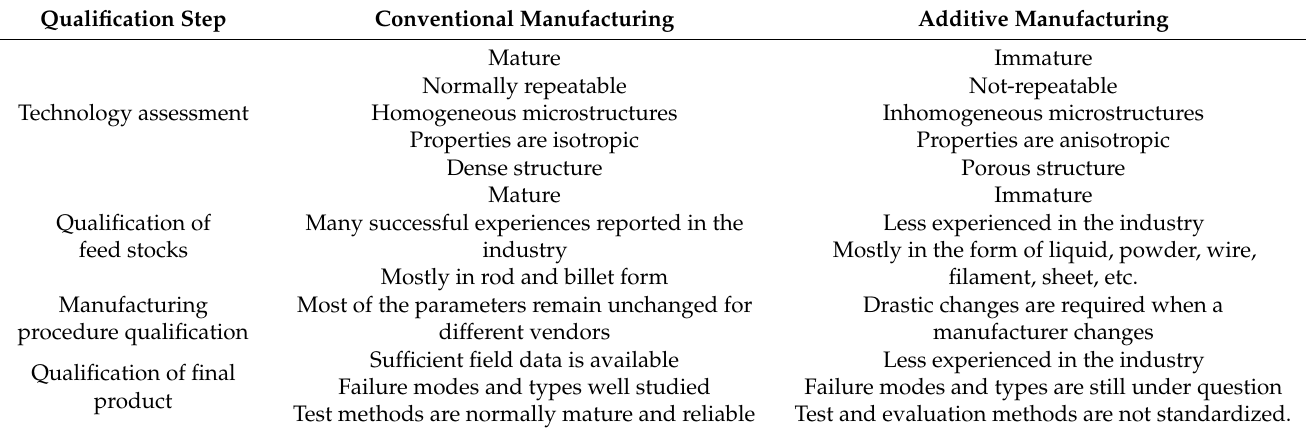
Table 1. Qualifications features of additive and conventional manufacturing